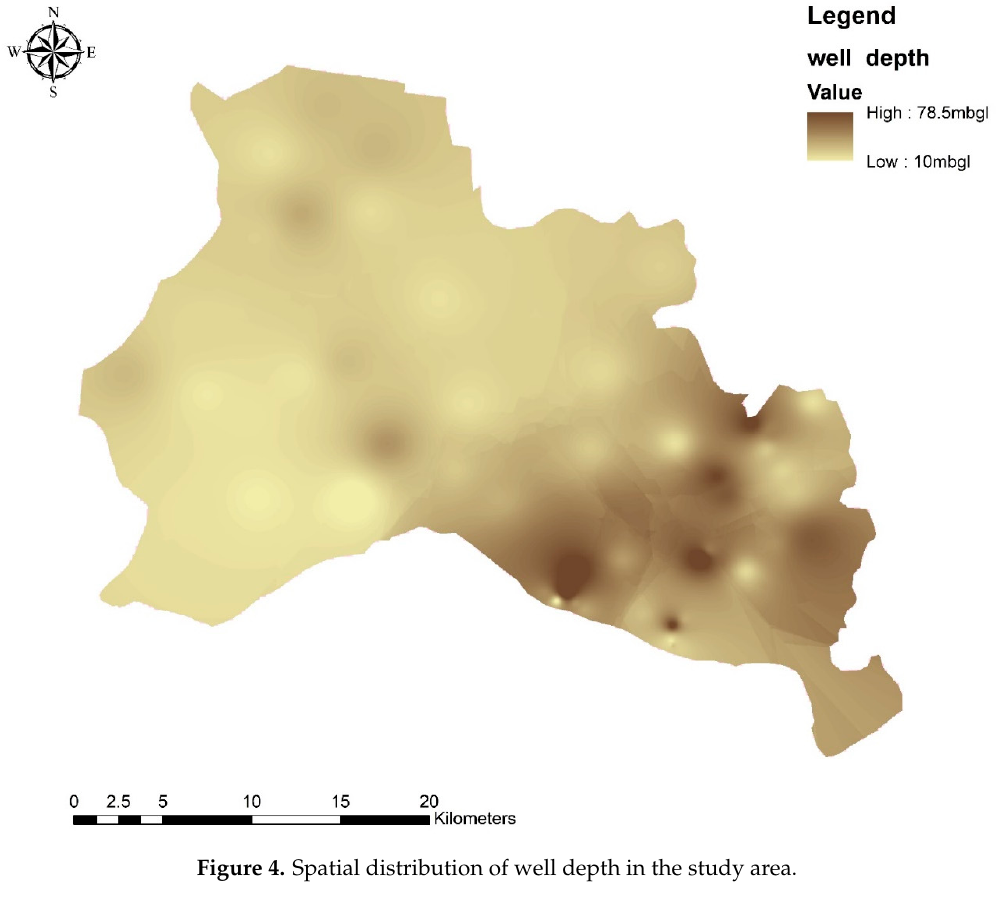
Figure 4. Spatial distribution of well depth in the study area.